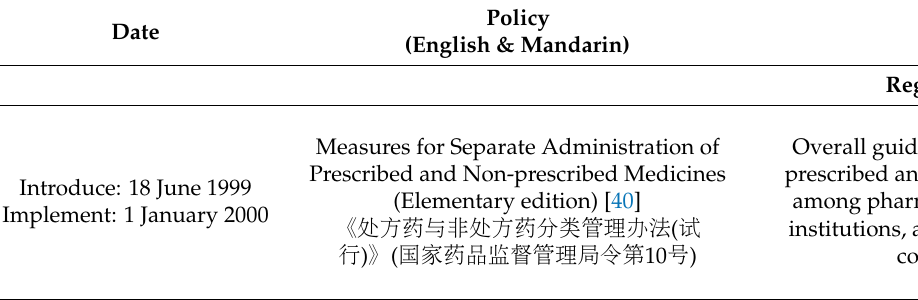
Table A1. Key regulations and strategies related to antibiotic sales in retail pharmacies in